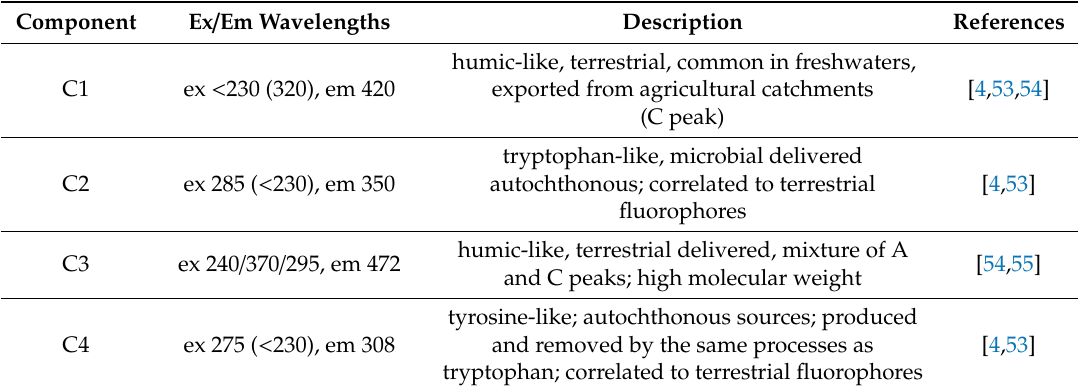
Table 1. Fluorescence characteristics and description of the four PARAFAC components identified by the PARAFAC model. Descriptions and references were taken from comparisons with the ‘openfluor’ database [52]. ex = excitation, em =